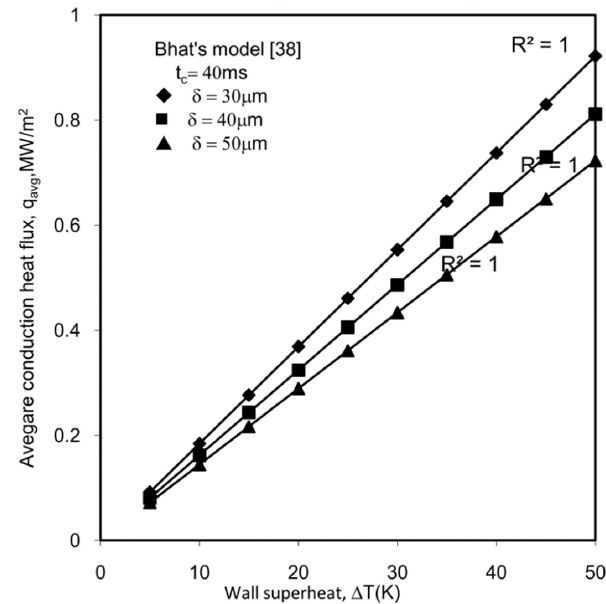
Figure 7. Effect of superheat on the average conduction heat flux at different δ with t c = 40 ms. Figure 7. E ff ect of superheat on the average conduction heat flux at di ff erent δ with t c = 40